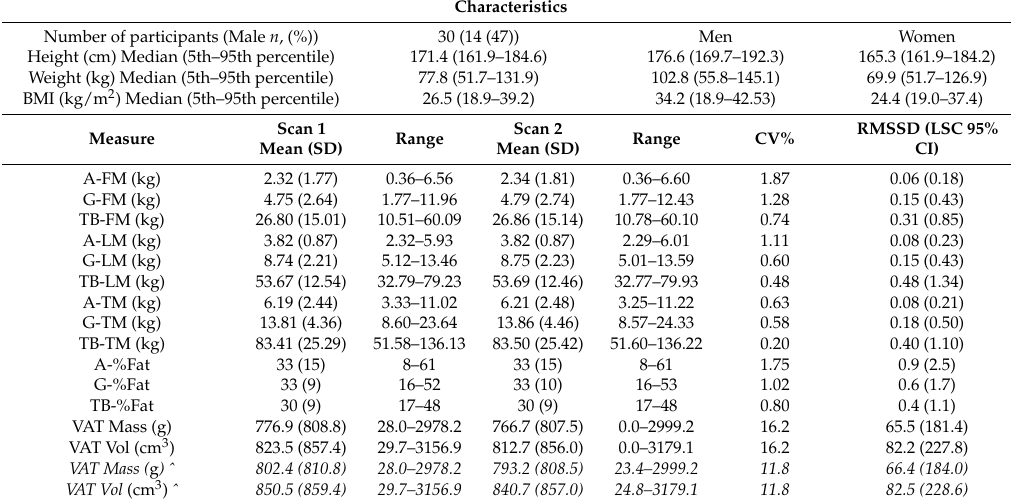
Table 2. Participant characteristics and scan results with coefficient of variation for body composition measurements for participants in the same-day repeated-scan precision